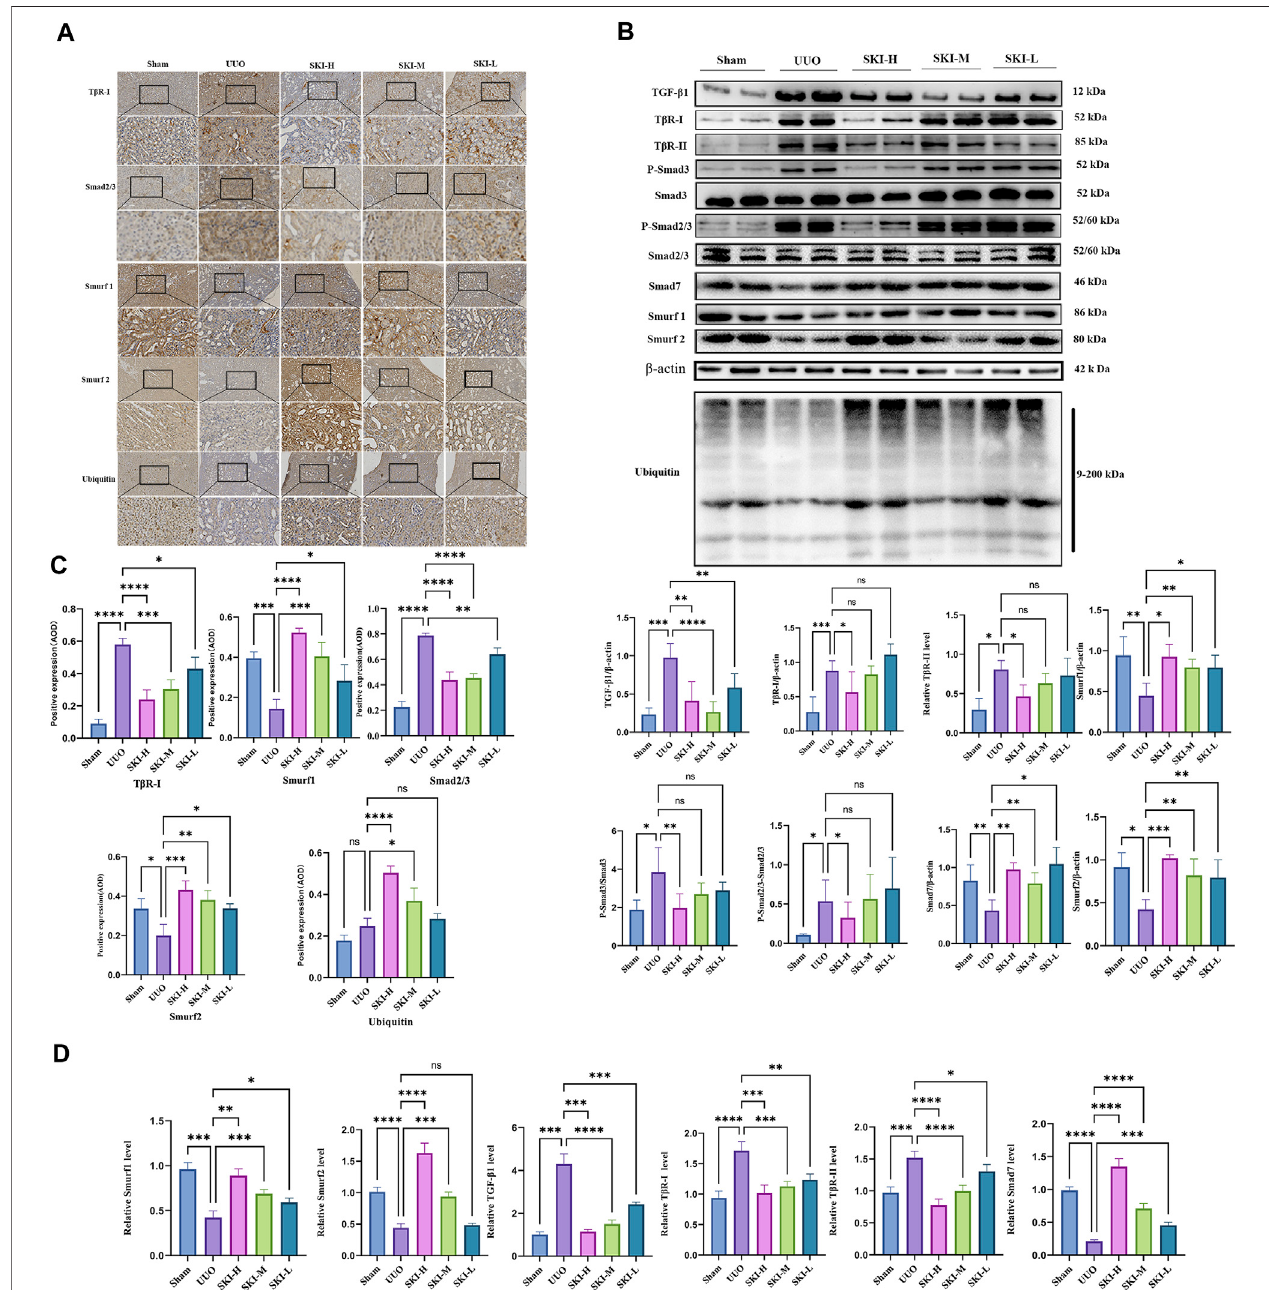
FIGURE 5 | Effect of Shenkang injection on protein of TGF- β /Smads signaling pathway. (A) T β R-I, Smad2/3, Smurf1, Smurf2, and ubiquitin protein expression, Scale: 100 um (200×). (B) Western blotting of Smad7, P-Smad3, P-Smad2/3, T β R-I, T β R-II, Smurf1, Smurf2, and ubiquitin. (C) The average optical density (AOD) in kidney tissue sections by immunohistochemistry. (D) Mean optical density of renal tissue protein (AOD).